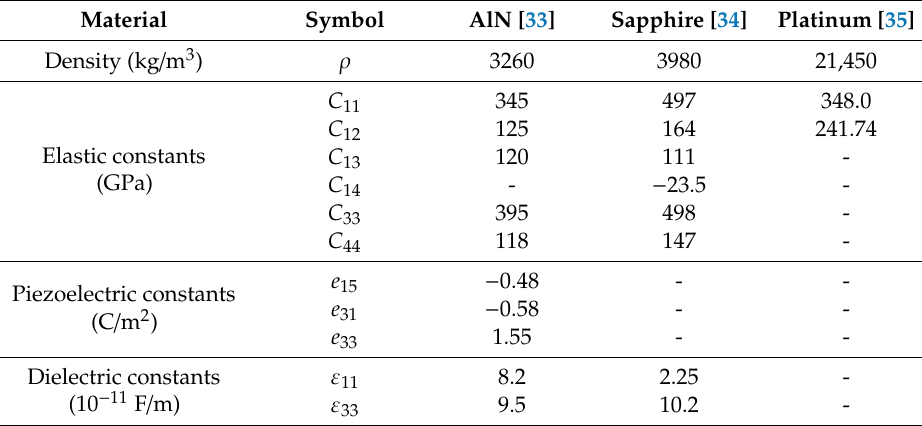
Table 2. Physical constants of AlN, Sapphire and Platinum.